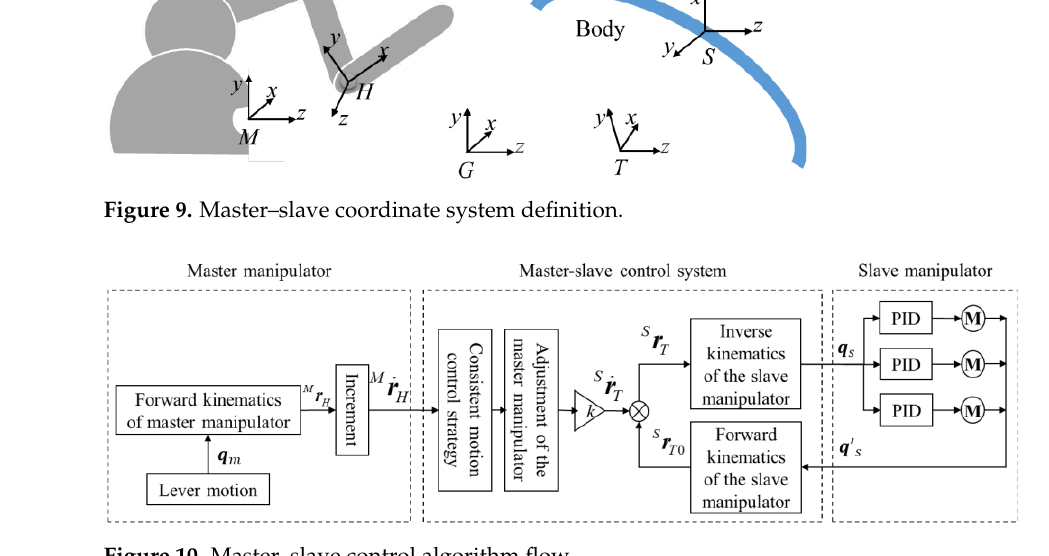
Figure 10. Master – slave control algorithm flow.